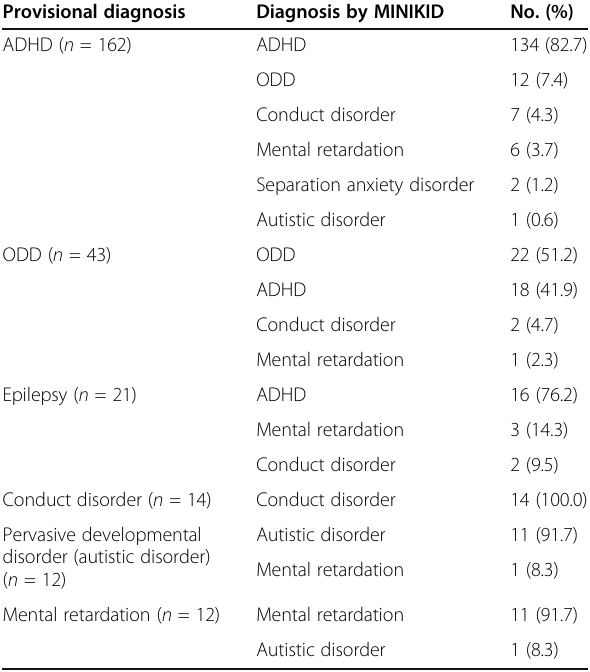
Table 6 Agreement of provisional diagnosis with MINIKID for each diagnosis Provisional